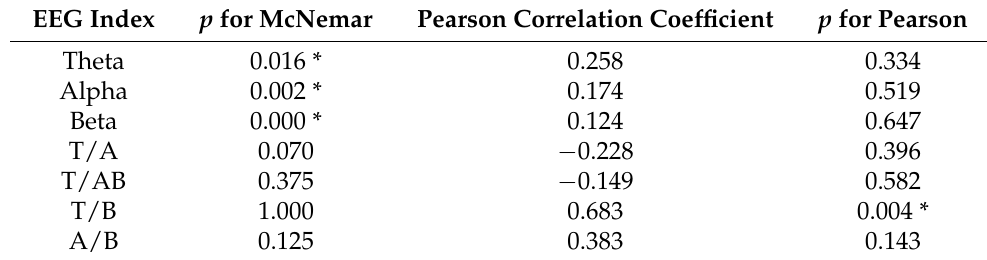
Table 4. Results of the McNemar test in Experiment 1.